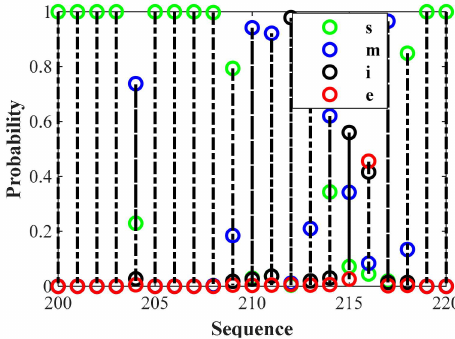
Figure 5. Probability result fragments of each brake intention